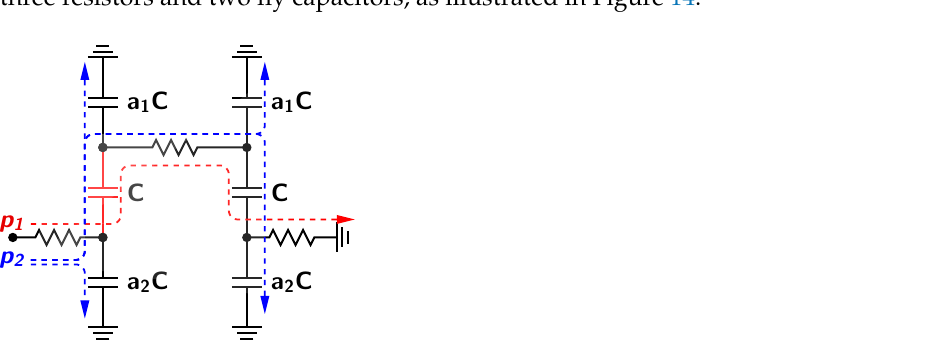
Figure 14. Charging and discharging paths between two consequent intermediate stages in